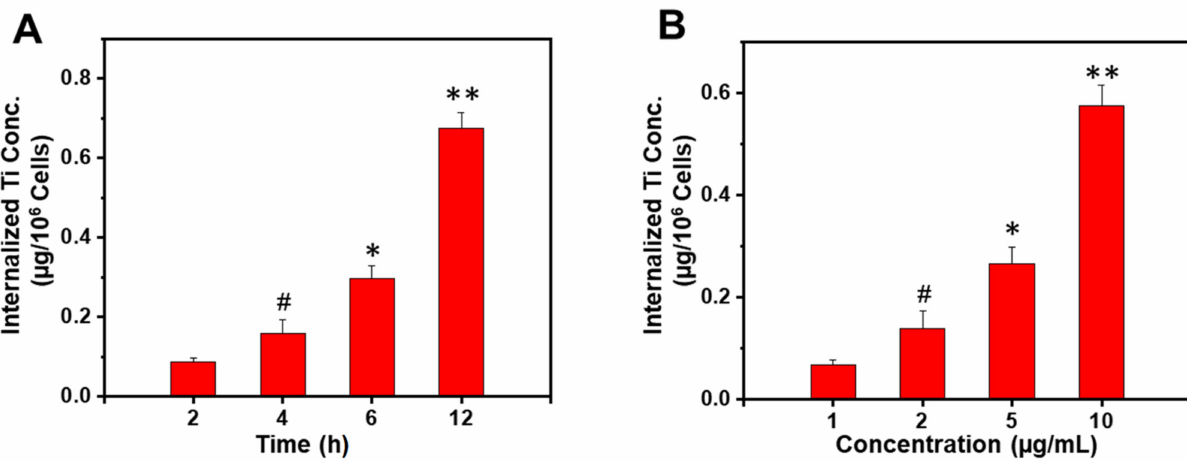
Figure 4. Cellular uptake of TiO 2 NPs by 4T1. ( A ) Time-dependent (5 µ g/mL TiO 2 concentration); ( B ) Concentration- dependent (6 h incubation). Data are expressed as a mean ± SD, (** P < 0.01, * P < 0.05, # P > 0.05, compared to the previous time or concentration